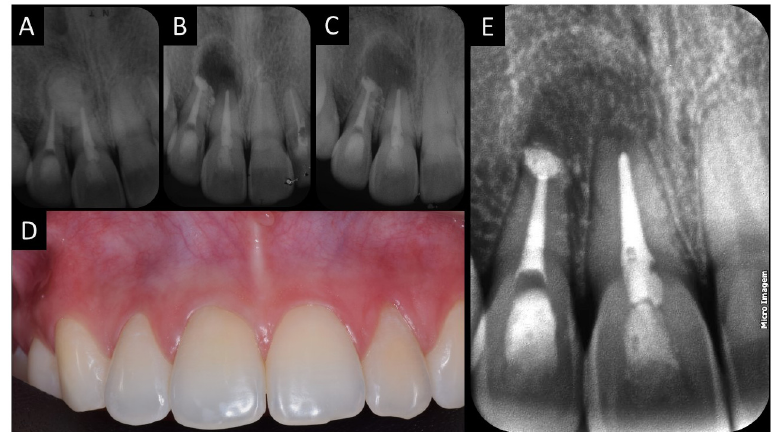
Figure 5. Radiographic preservation. A ) Periapical radiography of the endodontic treatment before surgery; B ) radiographic examination after excision of the odontoma and performing the apical retro-obturation of tooth 12; C ) 30 days after surgery; D ) and E ) 12 months after removal of the